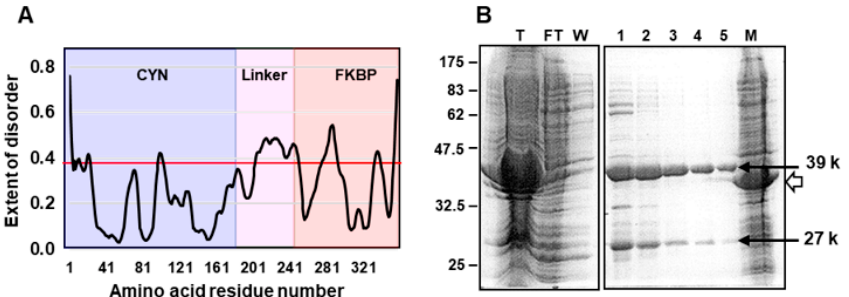
Figure 2. ( A ) Intrinsic disorder in the linker peptide region (the central pink area), connecting the CYN and FKBP domains in FjCFBP39 of Flavobacterium johnsoniae (GenBank WP_012024434.1), computed with PrDOS (prdos.hgc.jp), as previously described [19]. The red horizontal line is the baseline for disorder cutoff, set at 10% false-positive rate. Another small peak above this line (around residue 290), is a short loop region, visible and conserved in the FKBP crystal structures, and thus, not considered “intrinsically disordered” [19]. The domain areas are color-coded as in Figure 1: CYN, cyan; linker, pink; FKBP, salmon. ( B ) Fragmentation of FjCFBP39 during purification. The coding sequence of FjFCBP39 was cloned with N-terminal His-tag in pET15b plasmid, and expressed in Escherichia coli BL21 (DE3) pLysS, as described before [16]. Attempts were made to purify the recombinant protein by standard Ni +2 -agarose affinity chromatography [16] (Novagen Inc, Madison, WI, USA) and fractions at various steps of purification were analyzed by sodium dodecyl sulfate-polyacrylamide gel electrophoresis (SDS-PAGE), followed by staining with Coomassie Blue. Protein molecular weight markers of the indicated Mr (relative mobility) are shown at left. The prospective bands of the full-length protein of the structure His-CYN-linker-FKBP and Mr 39 k, and its putative His-CYN fragment (following cleavage within the linker) of 27 k are indicated with arrows. The white arrowhead points to a 34 k band (lane M), corresponding to another, irrelevant recombinant protein in total bacterial extract, used as molecular weight marker. The other lanes are as follows: T, total bacterial lysate containing FjFCBP39; FT, column flow-through (unbound proteins); W, wash (to remove unbound proteins); lanes 1–5, gradual fractions eluted with 0.5 M imidazole buffer, as recommended by the manufacturer. Note the presence of approximately equimolar amounts of the 39 k and 27 k bands in all fractions. The FKBP part does not bind to the column because it is at the C-terminus, lacking His-tag.